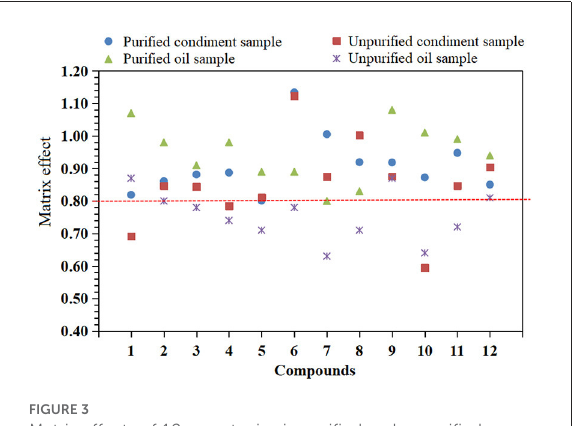
FIGURE3 Matrix effects of 12 mycotoxins in purified and unpurified condiments and oil